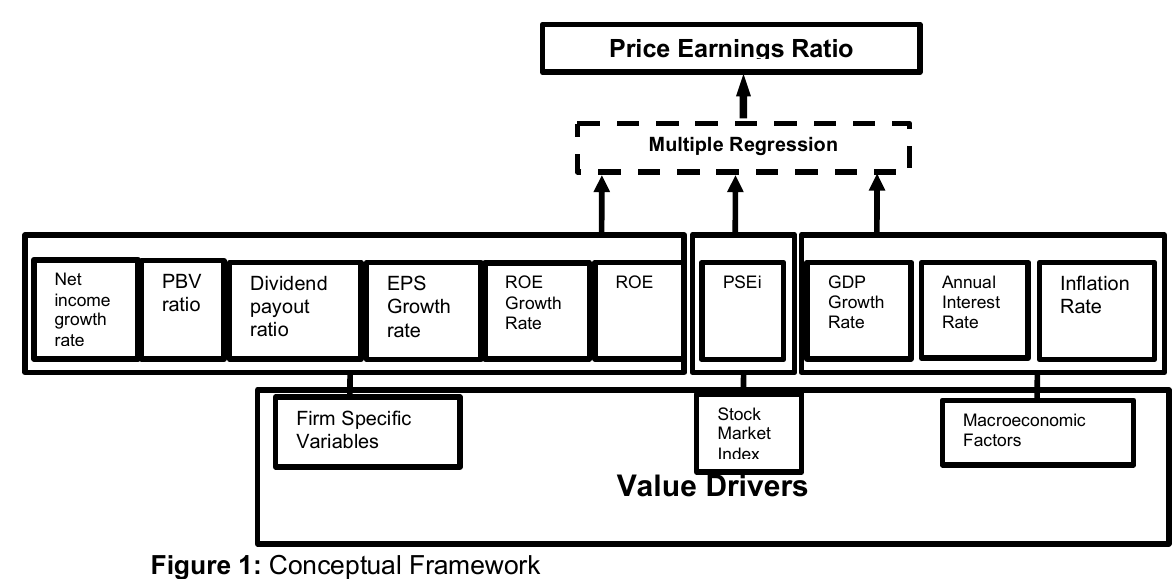
Figure 1: Conceptual